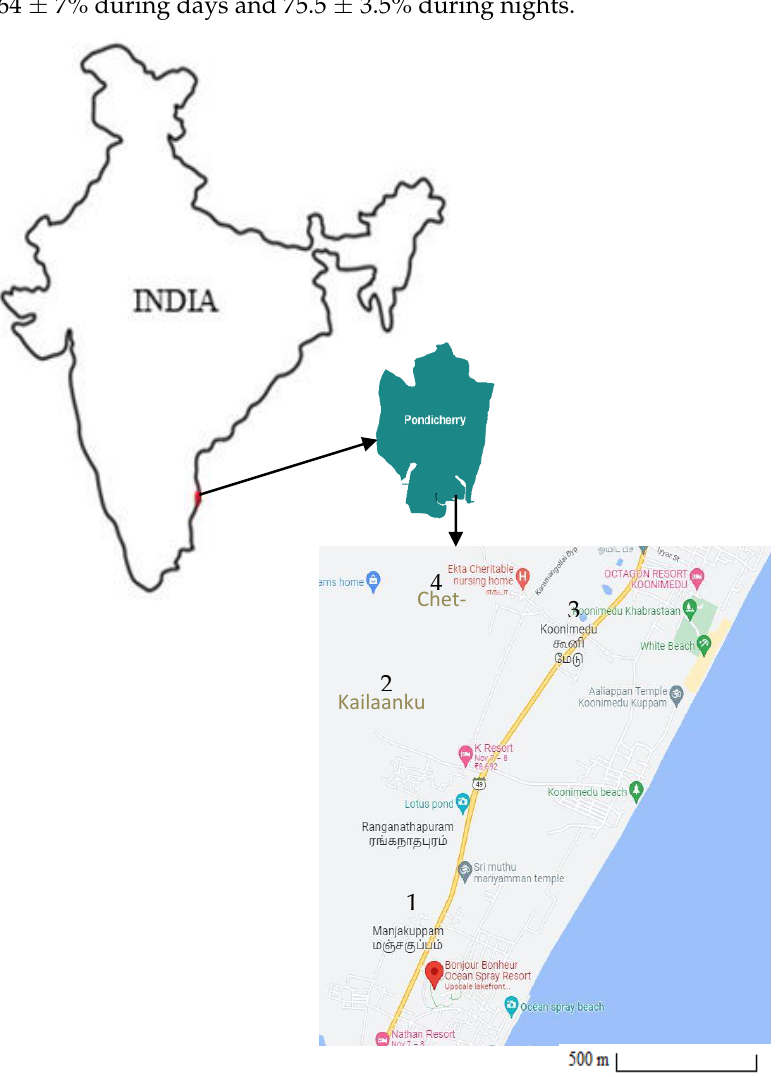
Figure 1. Location of the study area.